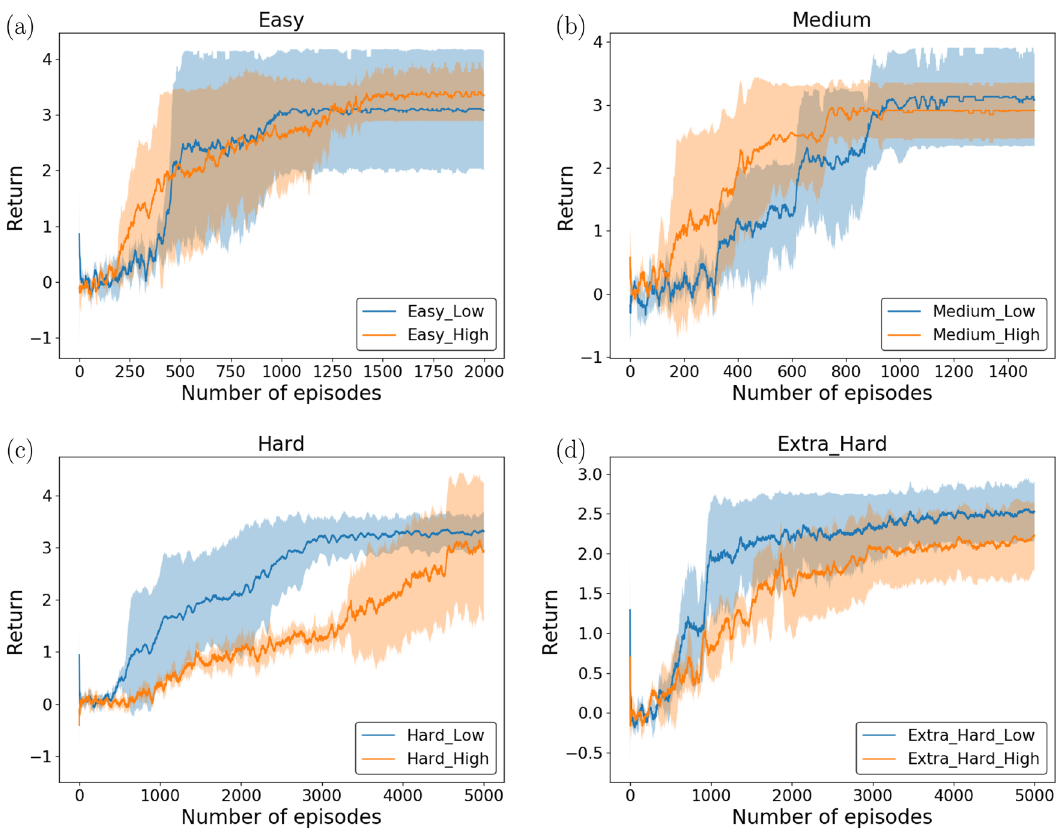
Fig. 3 Deep RL performances on various experiments. a Easy, ( b ) Medium, c Hard, and d Extra Hard